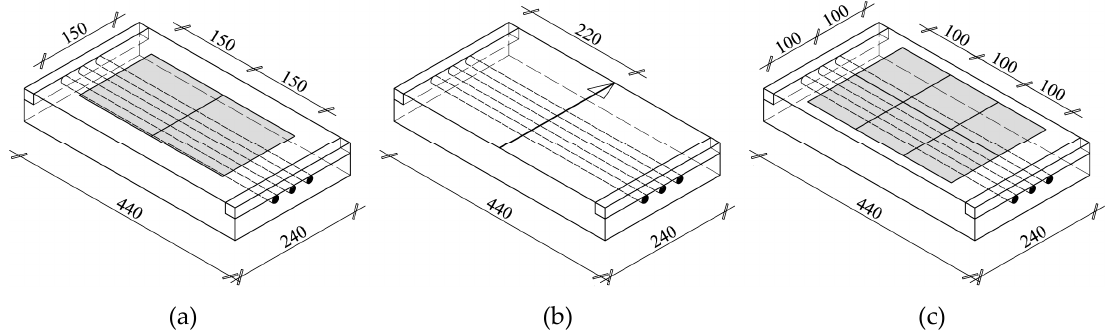
Figure 12. Location of tests performed with: ( a ) electromagnetic device (1), ( b ) electromagnetic device (2), ( c ) radar device (3). Materials 2019 , 12 FOR PEER REVIEW